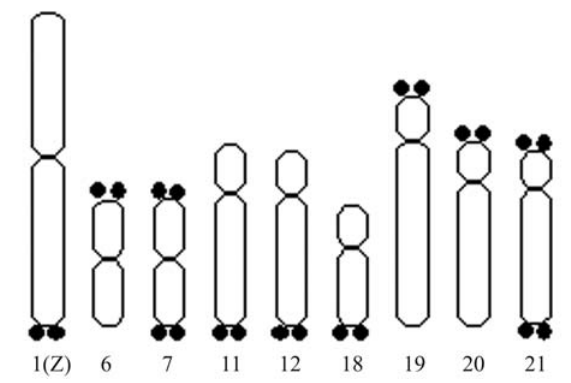
Figure 4 - Ideogram representing the physical mapping of 18S rDNA genes (indicated as black dots) in the chromosomes of Triportheus venezuelensis